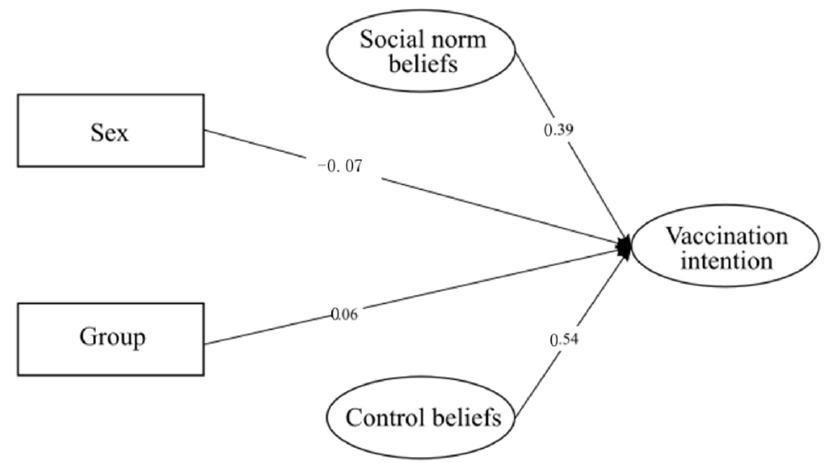
Figure 2. Simplified SEM model for Study 2 with only significant values.